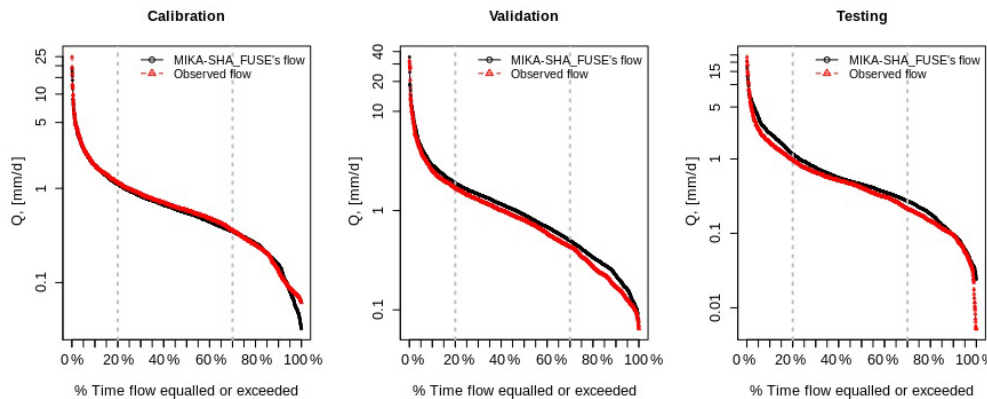
Figure 10. Simulated FDCs of MIKA-SHA_FUSE with the observed FDCs of the